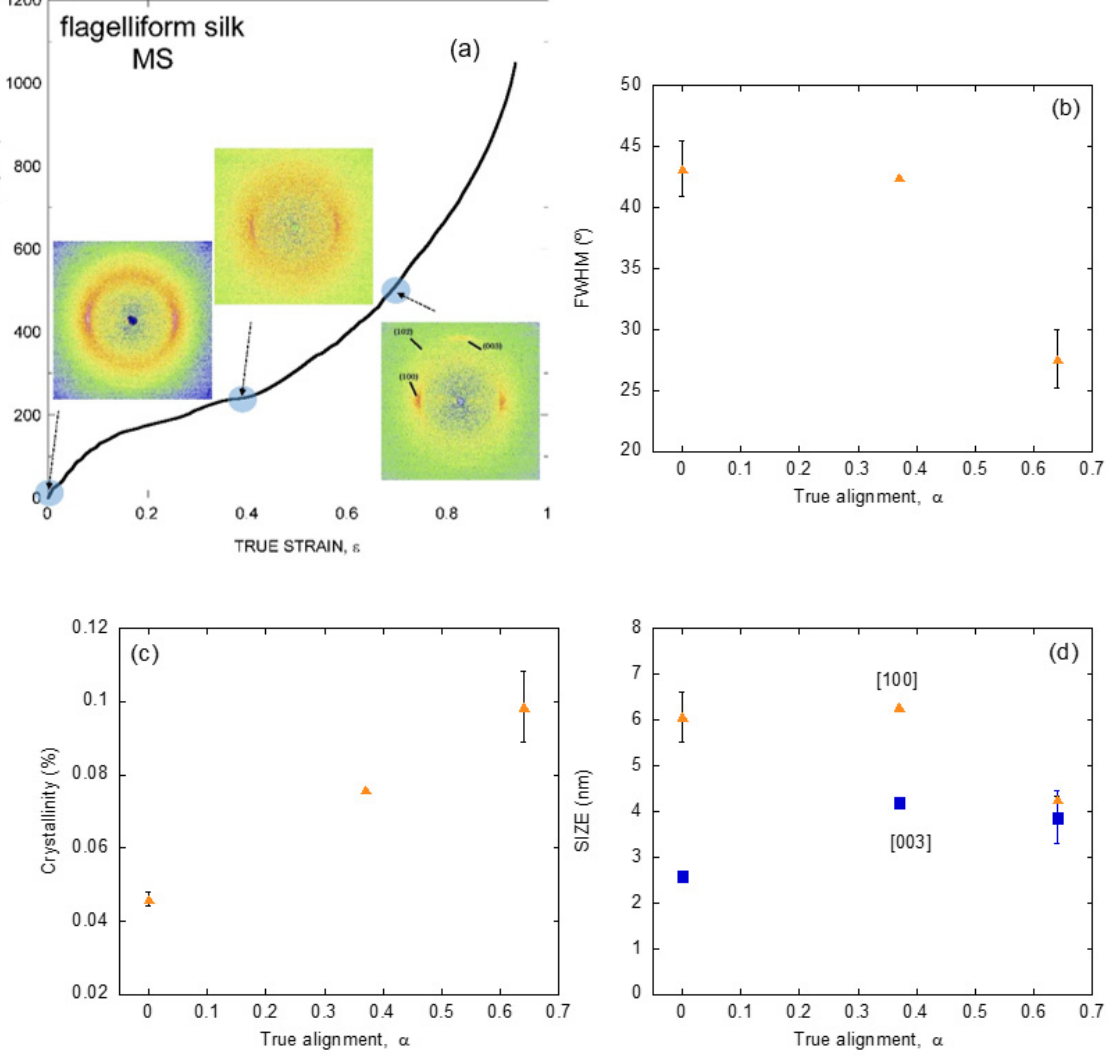
Figure 5. ( a ) X ray diffraction patterns obtained from individual Argiope trifasciata flagelliform (or viscid) spider silk fibers subjected to different values of stretching from the maximum supercontracted state. The approximate value of the corresponding alignment parameter is indicated on an MS curve. ( b ) Evolution of the orientation of the nanocrystals with increasing values of the alignment parameter. ( c ) Evolution of the crystallinity of the fibers with increasing values of the alignment parameter. ( d ) Evolution of the size of the nanocrystals as a function of the alignment parameter. The experimental details may be found in the corresponding references by the authors cited in the main text.